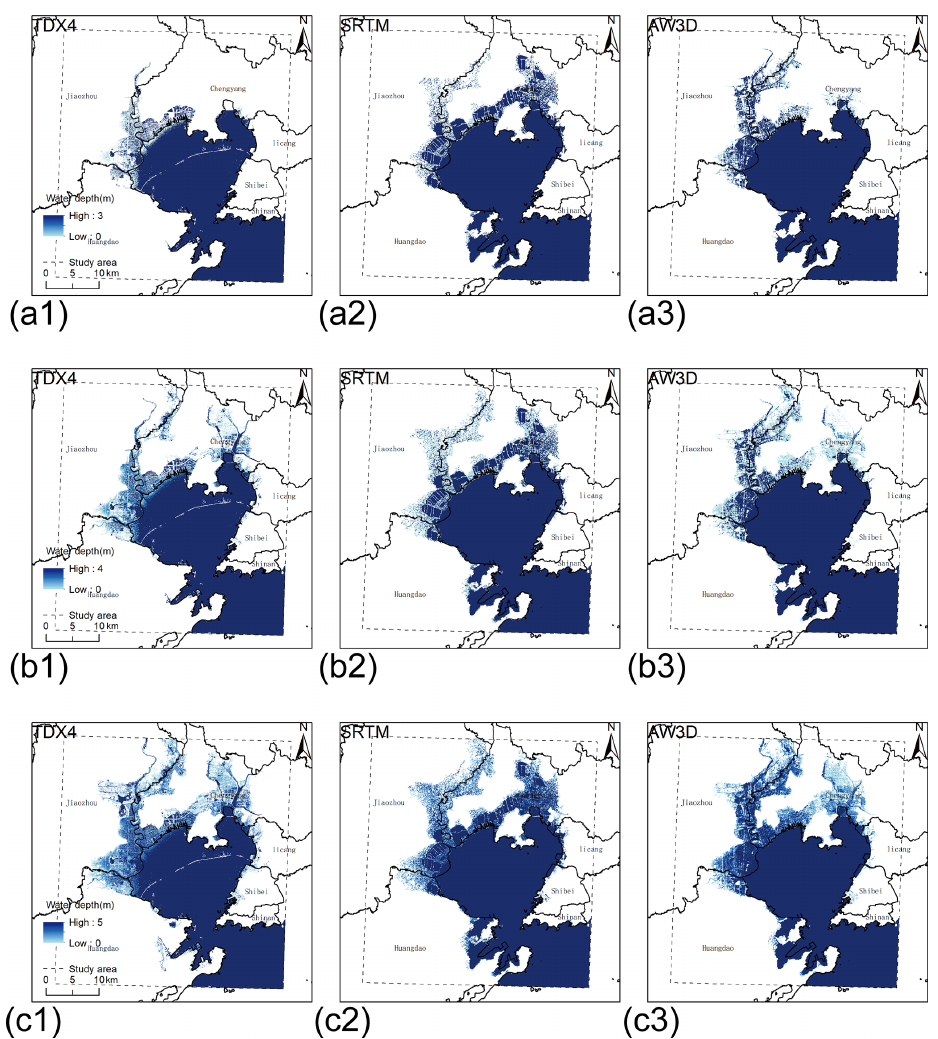
Figure 2. Inundation map with scenario (a) 2.7m, (b) 3.7m, (c) 4.7ma.m.s.l. and three different DEMs.